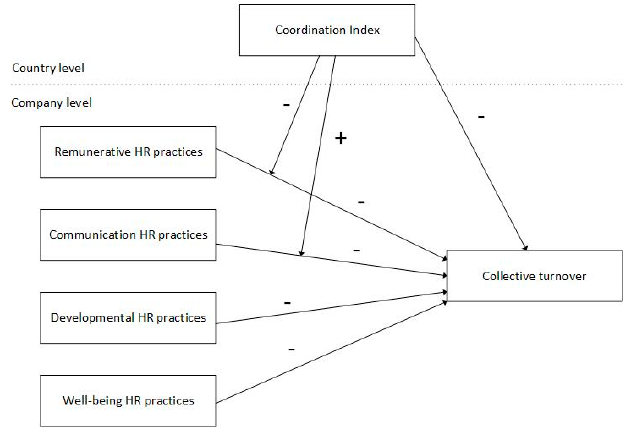
Figure 1 Conceptual model. Figure 1. Conceptual